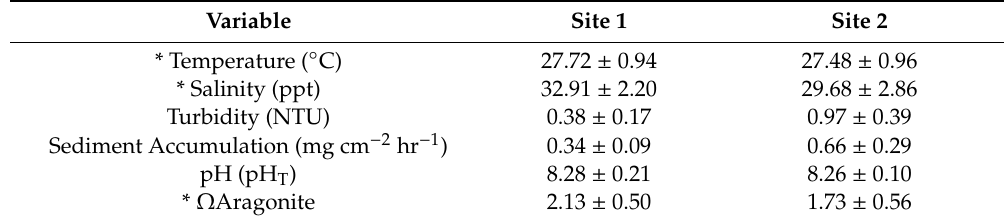
Table 1. Environmental parameters for each site.